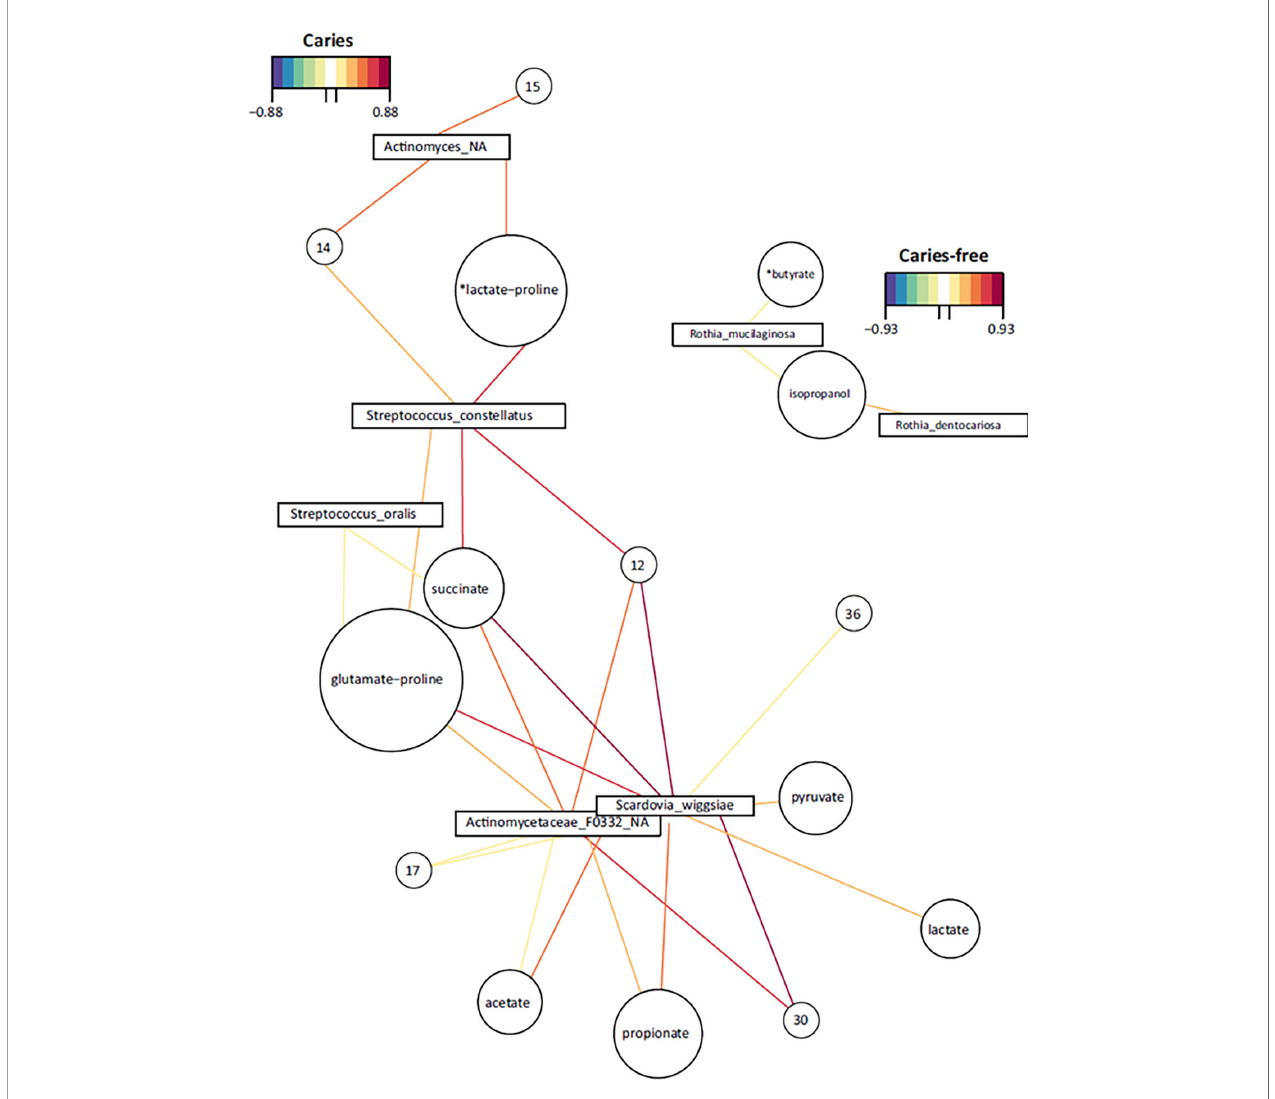
FIGURE 6 | Bacteria-Metabolites networks in dental plaque samples. Representative networks with signi fi cant correlations from caries-experienced (CAR) and caries-free (CF) adolescents are shown. Positive and negative signi fi cant correlations between individual species (squares) and metabolites (circles) are represented with colored lines according to the palettes. The size of the circles is arbitrary. Metabolites were identi fi ed by NMR analysis and those compounds with non-unique peaks are marked with an asterisk to indicate their putative assignment. Compounds marked with numbers could not be assigned to a known